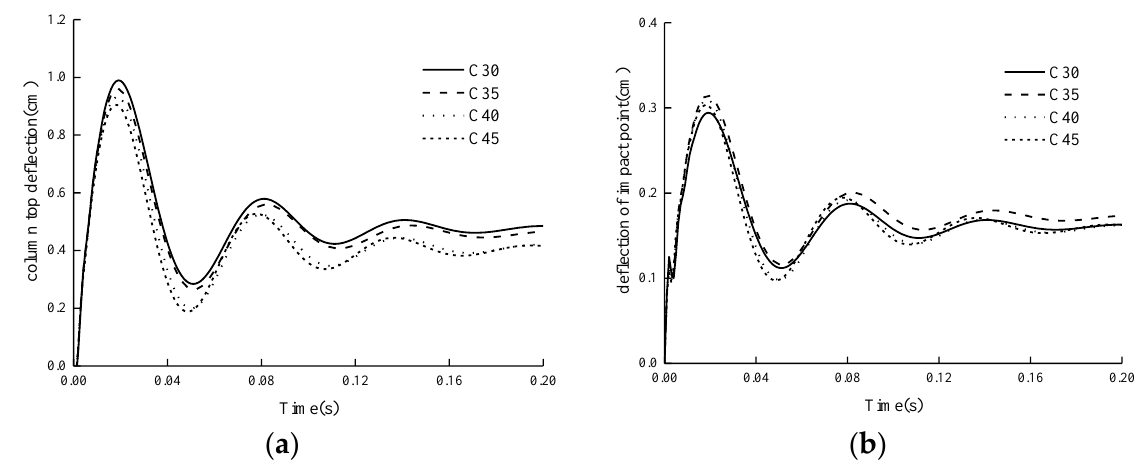
Figure 21. Impact deflection of model columns with different concrete strengths: ( a ) relationship between column top deflection and concrete strength; ( b ) relationship between deflection of impact point and concrete strength.